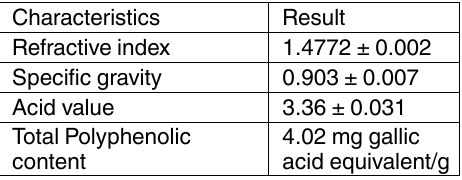
table 1. The physico-chemical characteristics of essential oil of nutmeg fruit